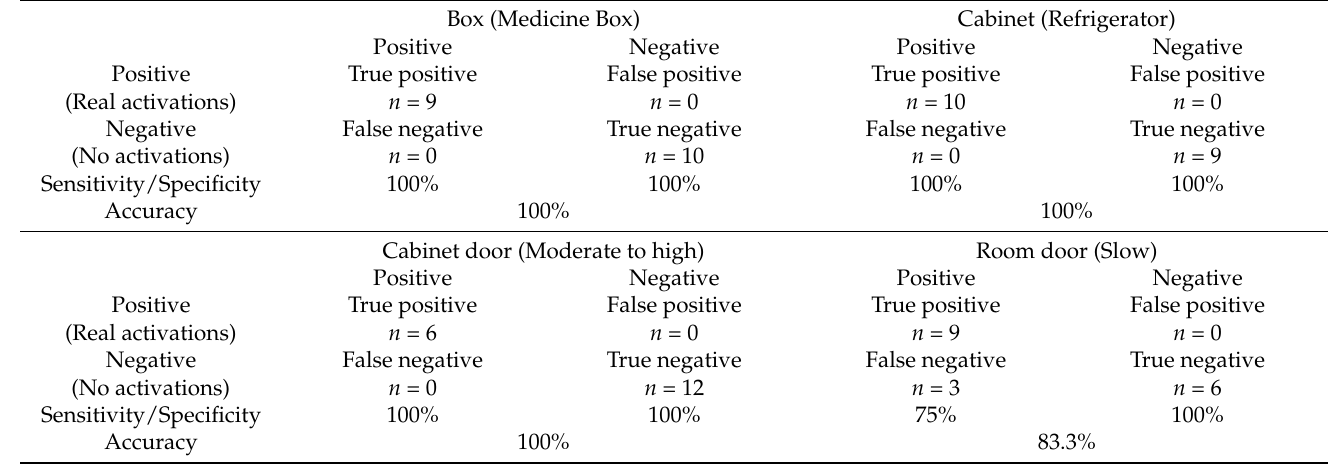
Table 1. Results of the sensitivity and specificity for detection of the interaction times according to objects of interest and movement speeds.